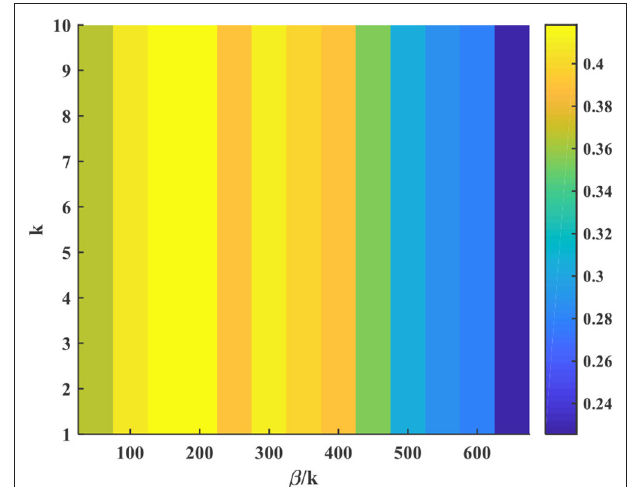
FIGURE 10 | AUC score of CANN on several videos.